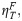
Sensitivity regarding the birth, death, thalassemia diagnosis rates with respect to thalassemia populations.(a) Sensitivity of bF, ηTF,
dGF,
dT and dF with respect to TF. (b) Sensitivity of bM, ηTM,
dGM,
dT and dM with respect to TM. Note that bM, bF are birth rates, dGM,
dGF are child mortality rates, dM, dF and dT are normal male and female death rates and thalassemia induced death rates, respectively.